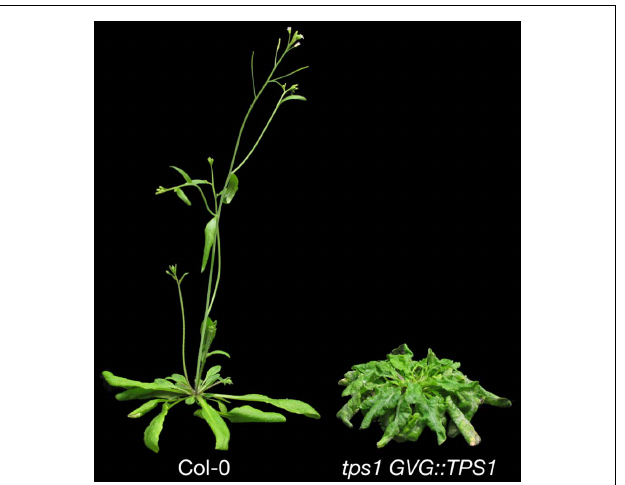
FIGURE 2 | Plants defective in trehalose-6-phosphate synthesis are late flowering. Depicted are wild-type (Col-0) plants and homozygous tps1 mutants that carry a chemically inducible TPS1 rescue construct ( GVG :: TPS1 ), which flower late when compared to wild-type control. Plants were grown under long day photoperiod at 23˚C and the images were taken on 20 and 50days after sowing, for wild-type and homozygous tps1 mutant,